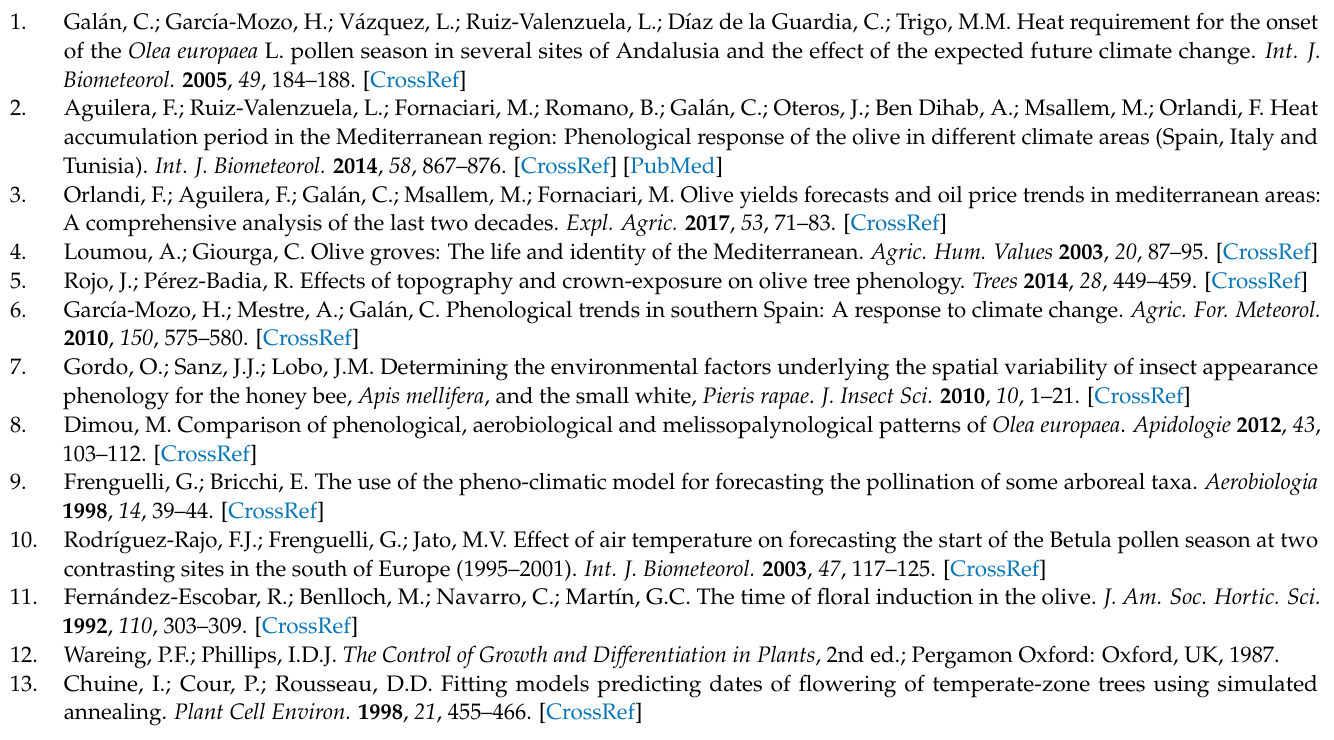
Figure S1: Pollen by anther, % of Germination am % of Viability with CA and TTC methods during the studied period with the mean, maximum, minimum, standard deviation (S.D.) and coefficient of standard variation in percentage